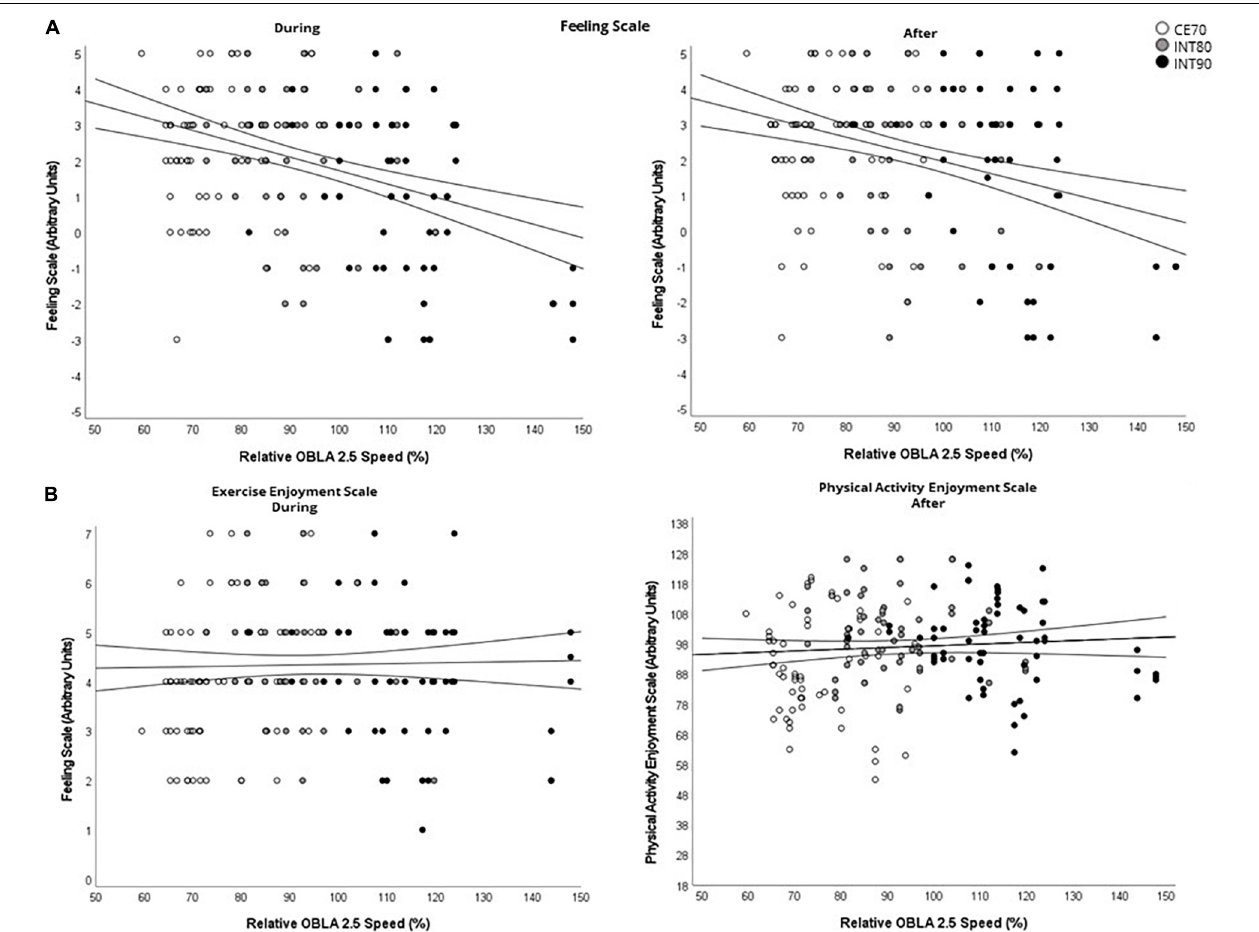
FIGURE 5 | Scatter plots illustrating the relationship between relative OBLA 2.5 running speed across all exercise sessions and weeks ( n = 180) and (A) all FS scores; significant correlation for Feeling Scale during- (Relative OBLA 2.5 Speed: r = –0.36, p < 0.01) and after the exercise sessions (Relative OBLA 2.5 Speed: r = –0.32, p < 0.01), (B) all PACES and EES scores; no significant correlations. Trend line for regression and 95% CI. OBLA, onset of blood lactate accumulation; CI, confidence interval; FS, feeling scale; PACES, physical activity enjoyment scale; EES, exercise enjoyment scale; RPE, rating of perceived exertion.